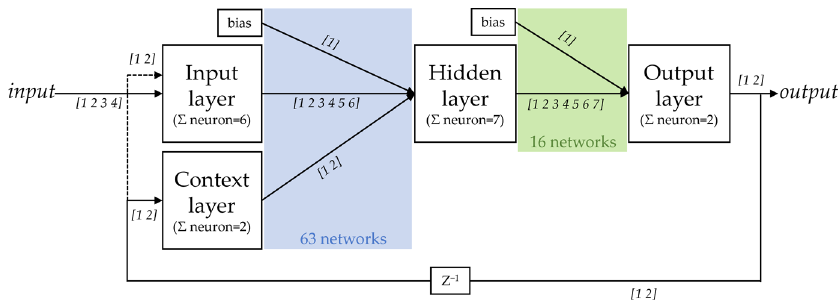
Figure 2. Modified Jordan neural network.